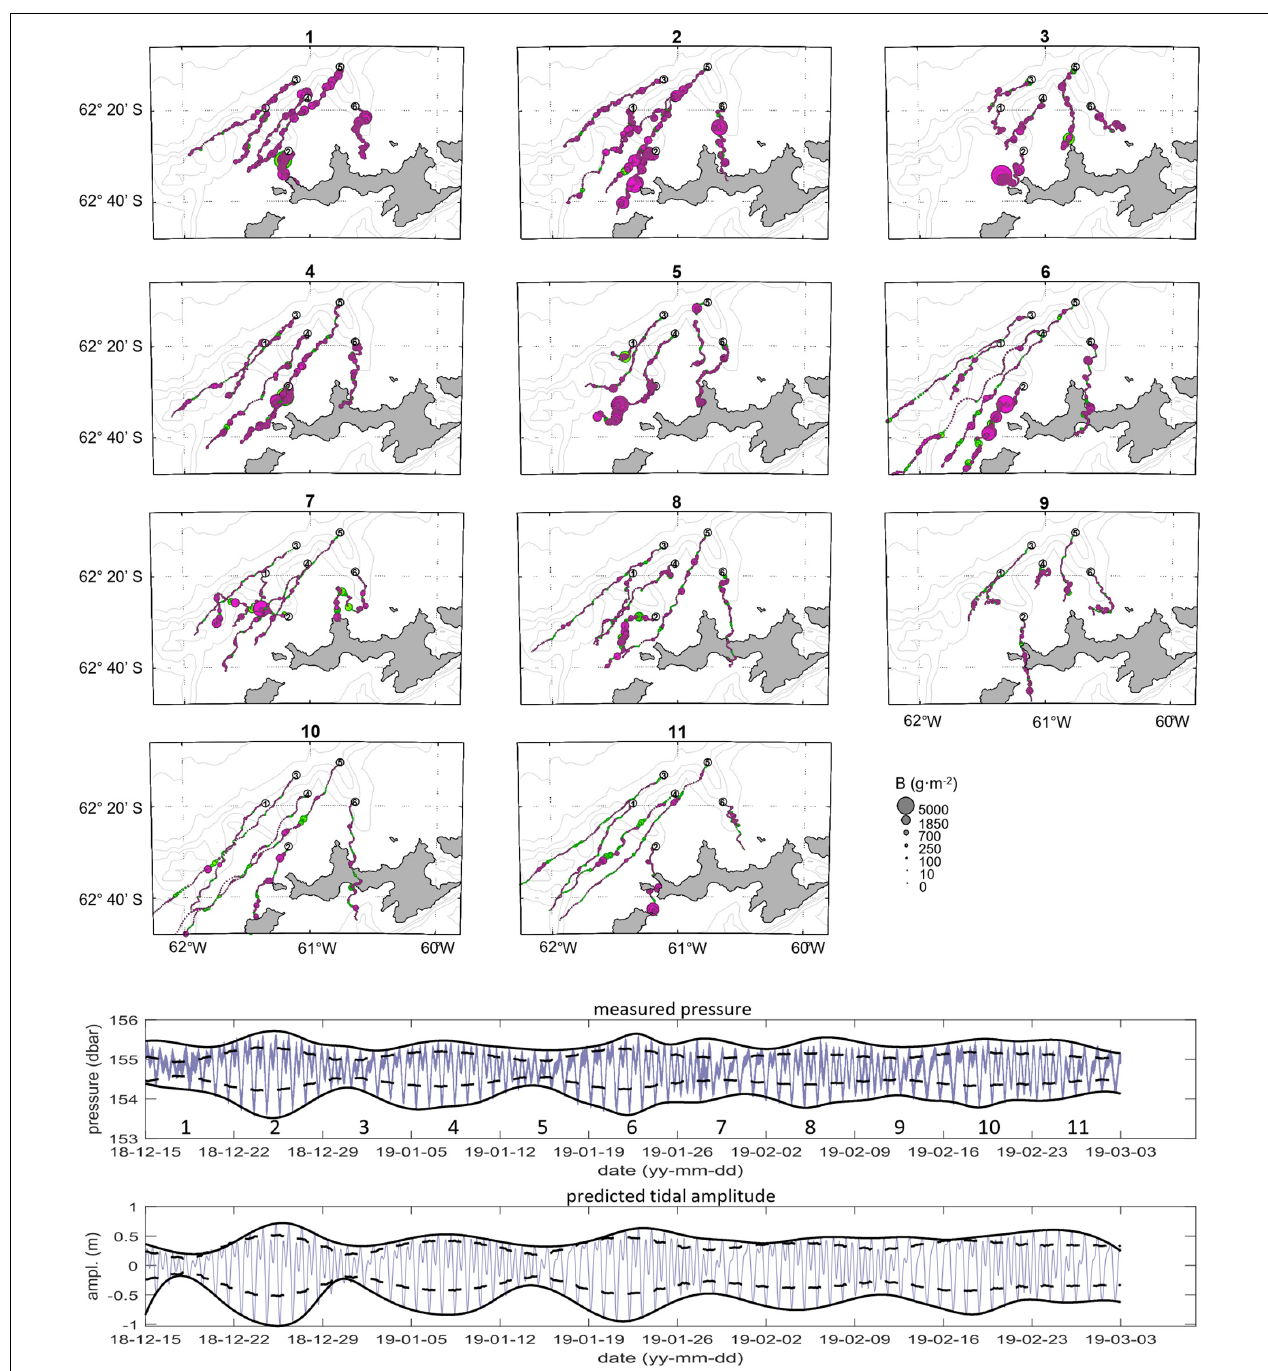
FIGURE 10 | Progressive vector diagrams (PVD) for each week (panels 1–11) during the survey period; points are sized by biomass density and colored by day (purple) and night (green). Below: measured pressure and predicted tidal amplitude. Time axis labels yy-mm-dd are two-digit year-month-day.